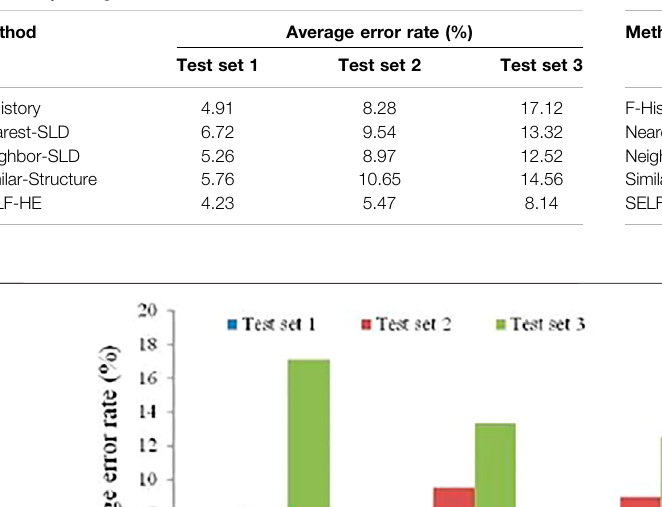
TABLE 2 | Average error rate using Test set